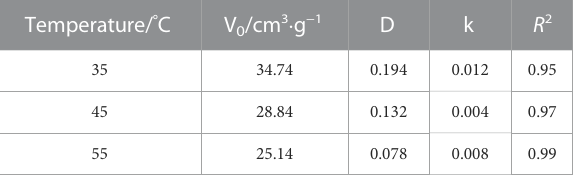
TABLE 4 D-R model fi tting parameters.